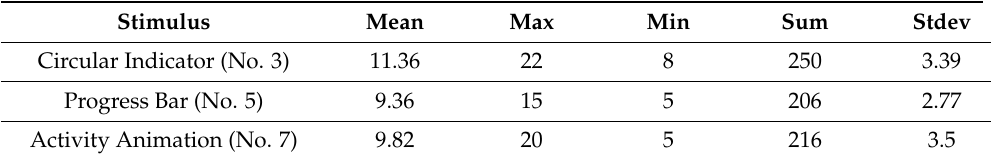
Table 4. Fixations in the eye-tracking